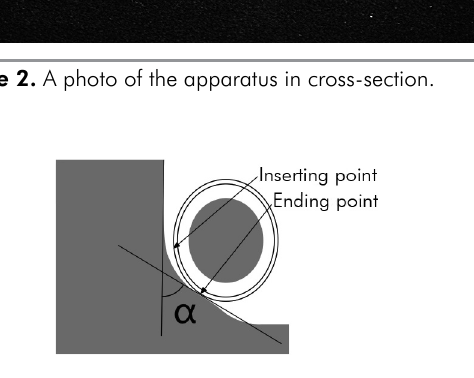
*The file was inserted from an insertion point 2 mm wide and ending at a 1 mm wide point. The angle of curvature α included the 45°, 60° and 90° canals. Figure 3. A schematic of the apparatus in